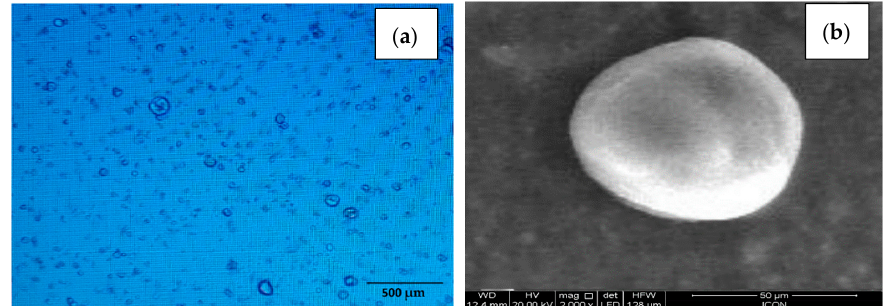
Figure 3. Image analysis with ( a ) Optical micrograph ( b ) SEM micrograph.